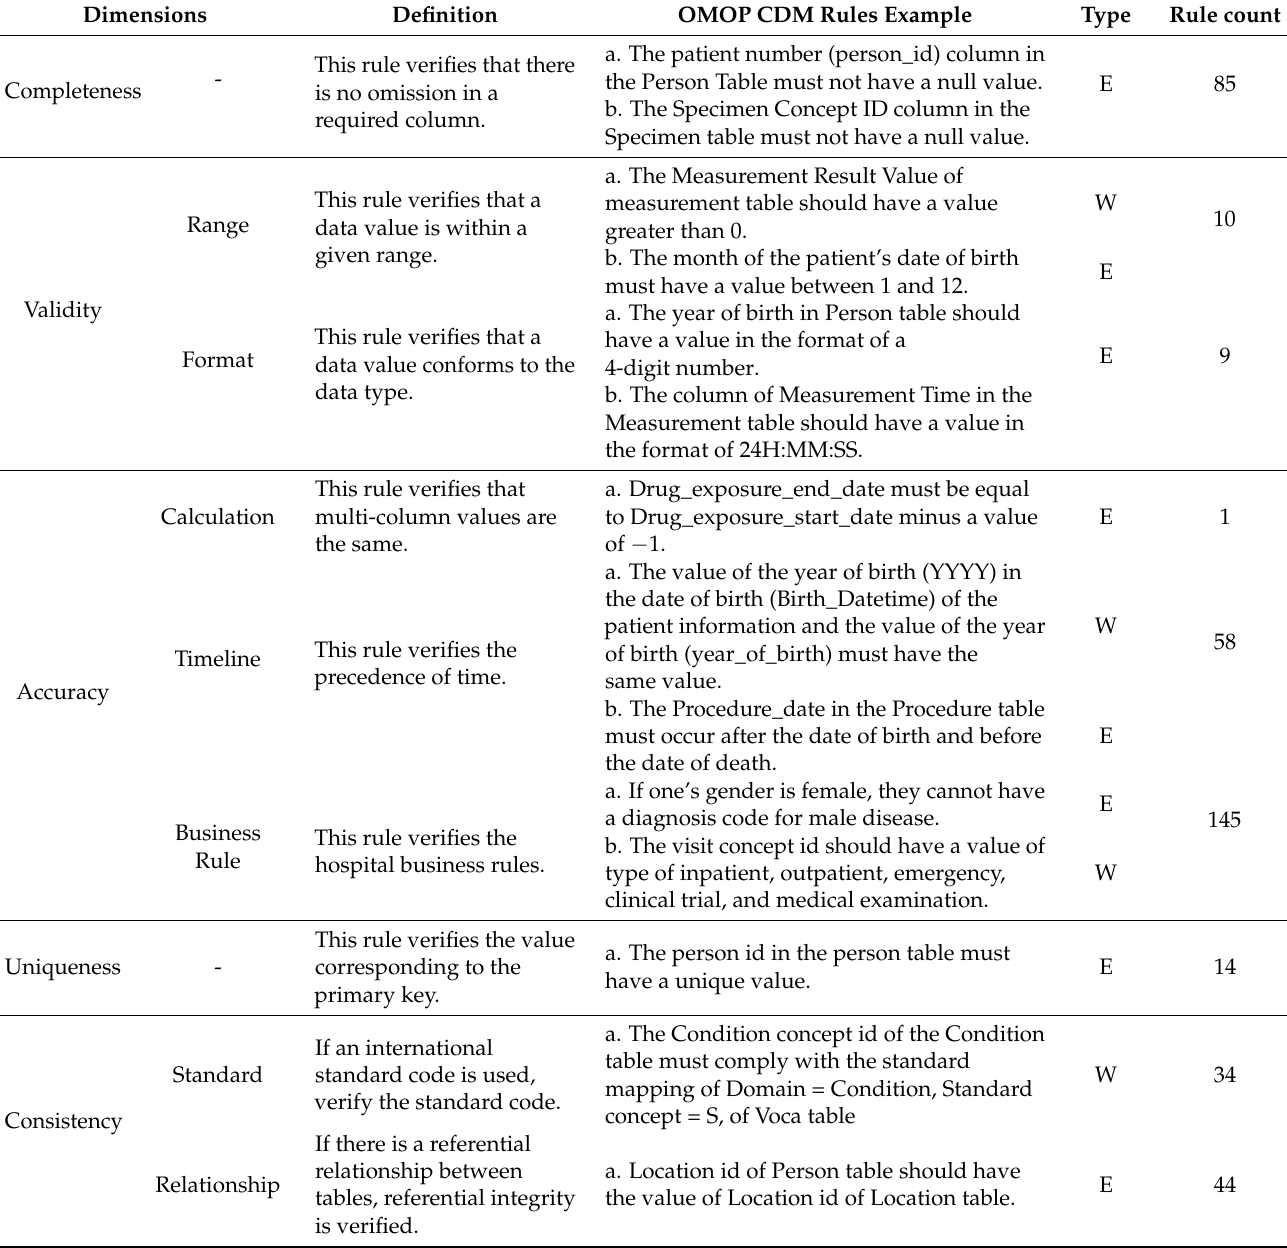
Table A2. DQ4HELTH (Data Quality for Healthcare) Model Development